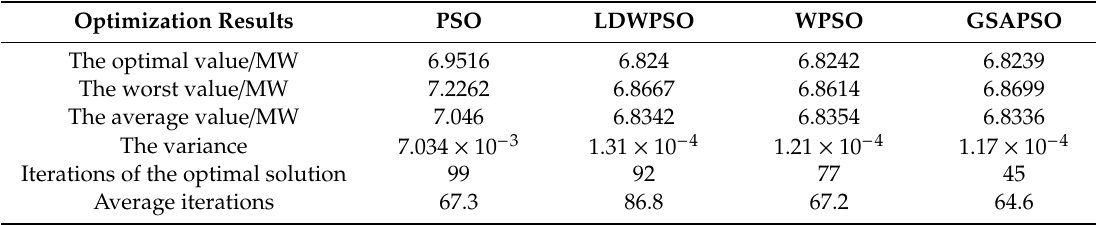
Table 5. The results with four